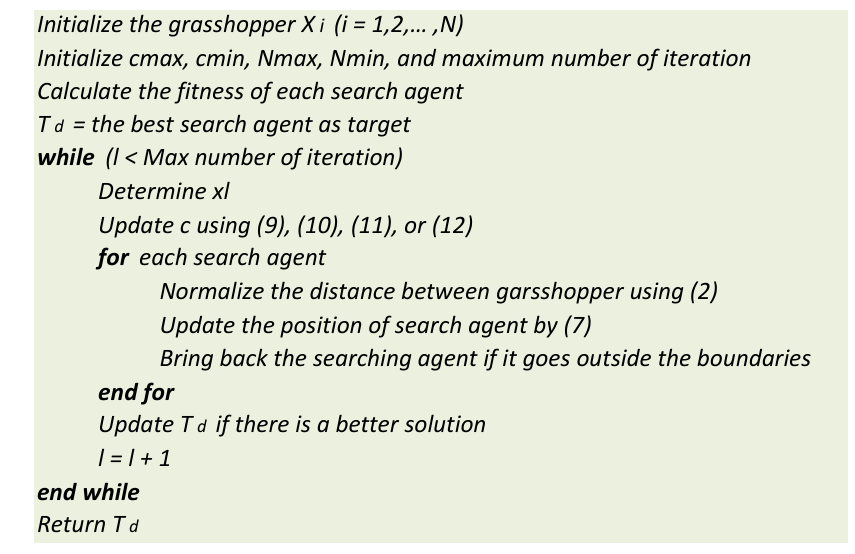
Figure 2. Pseudo-code of ECGOA.